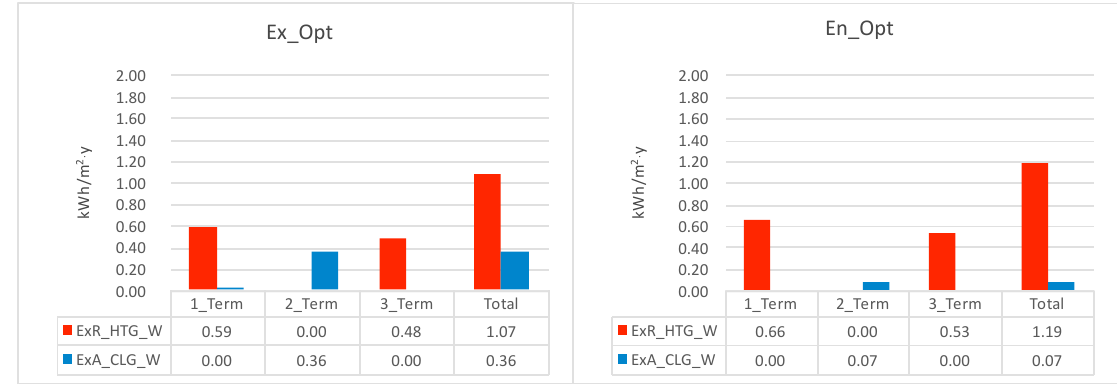
Figure 14. Exergy analysis in the water